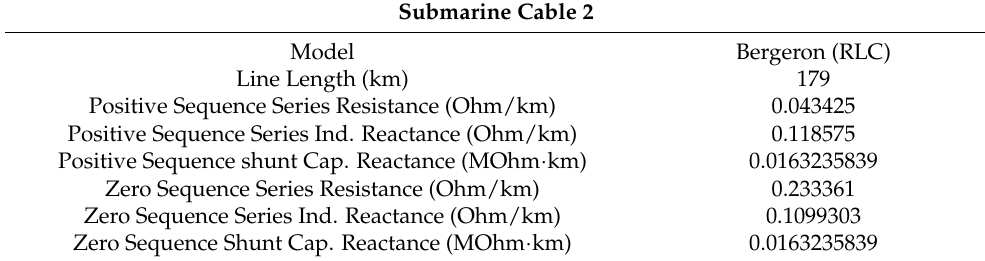
Table 14. Data of Submarine Cable 2.